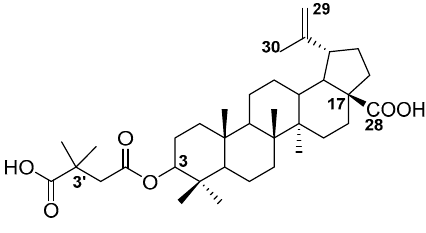
Figure 1. Chemical structure of bevirimat (BVM).